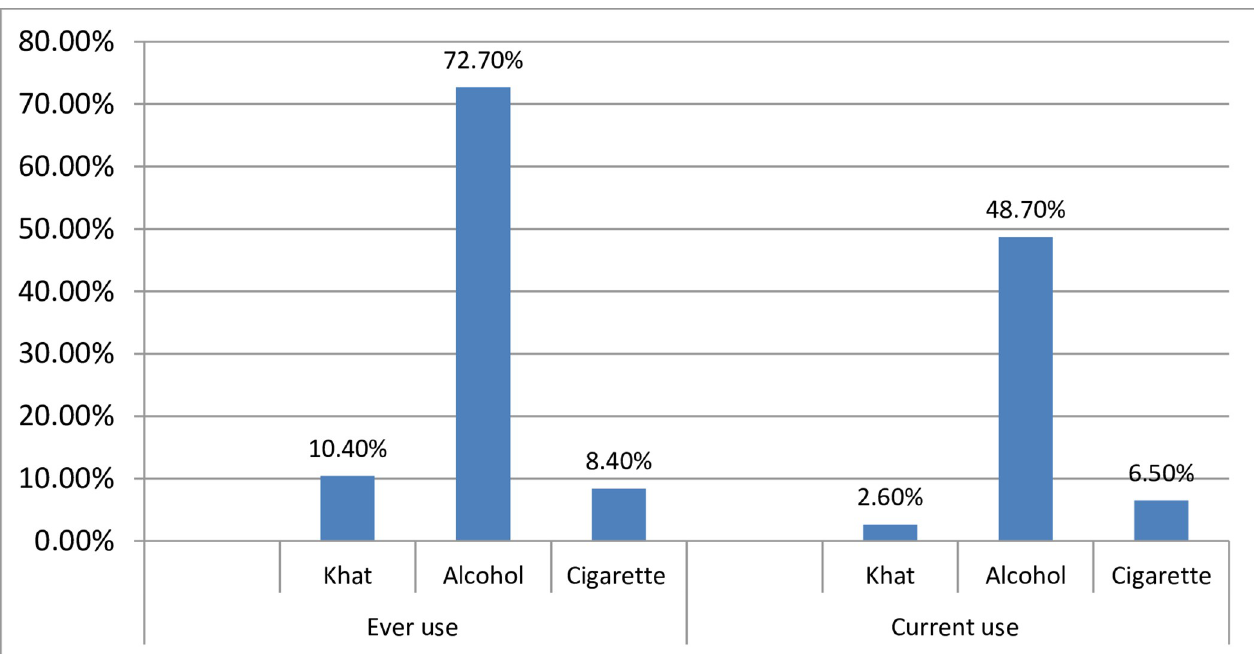
Fig 2. Substance-related factors of cognitive impairment in patients with epilepsy attending outpatient department of south Gondar zone hospitals Amhara Ethiopia 2020 /2021(n = 509).